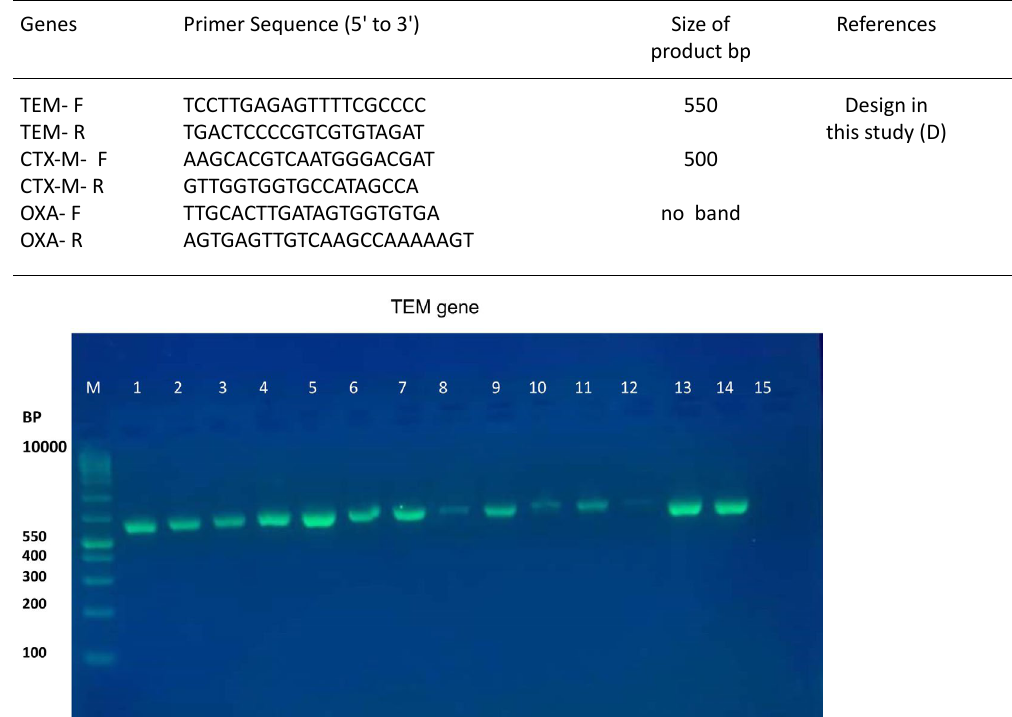
Fig. 3. Gel electrophoresis of PCR product TEM gene in K. pneumoniae isolates, M= DNA molecular size markers (100 bp), 1 to 15 represents number of isolates, 1% agarose gel at 5 Vol /cm for 1:15 hours